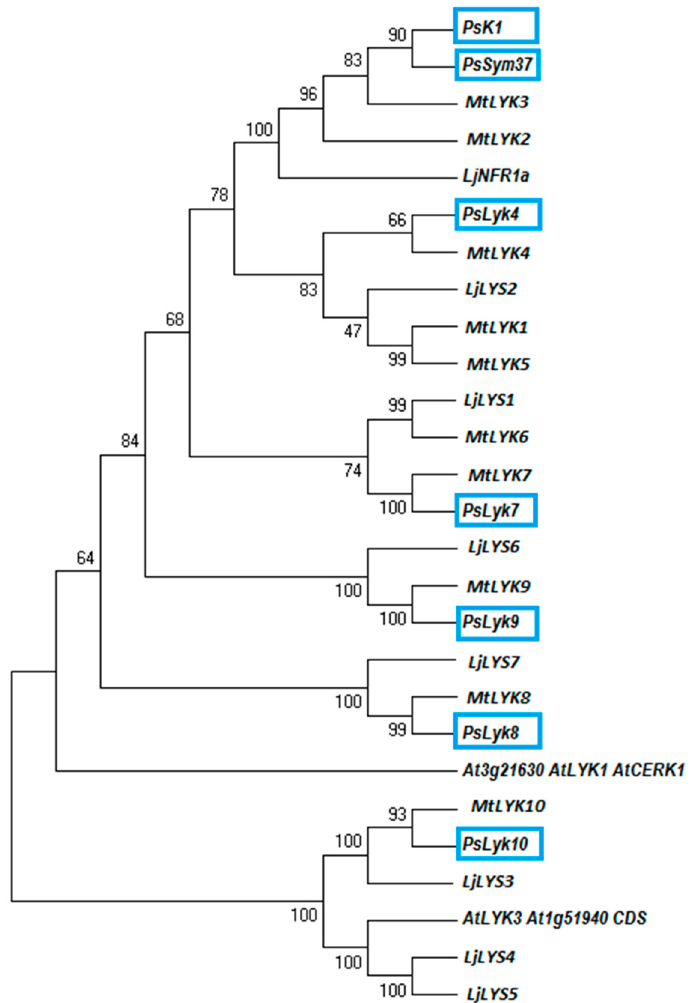
Figure 1. Phylogenetic tree analysis showing the evolutionary relationships of the legume representatives of the LYK group of LysM-RLKs. Maximum-likelihood branch lengths were calculated using full length encoding sequences of LYK genes. The blue boxes represent pea genes. The branches show the bootstrap values. Ps, Pisum sativum ; Lj, Lotus japonicus ; Gm, Glycine max ; Mt, Medicago truncatula ; At, Arabidopsis thaliana .